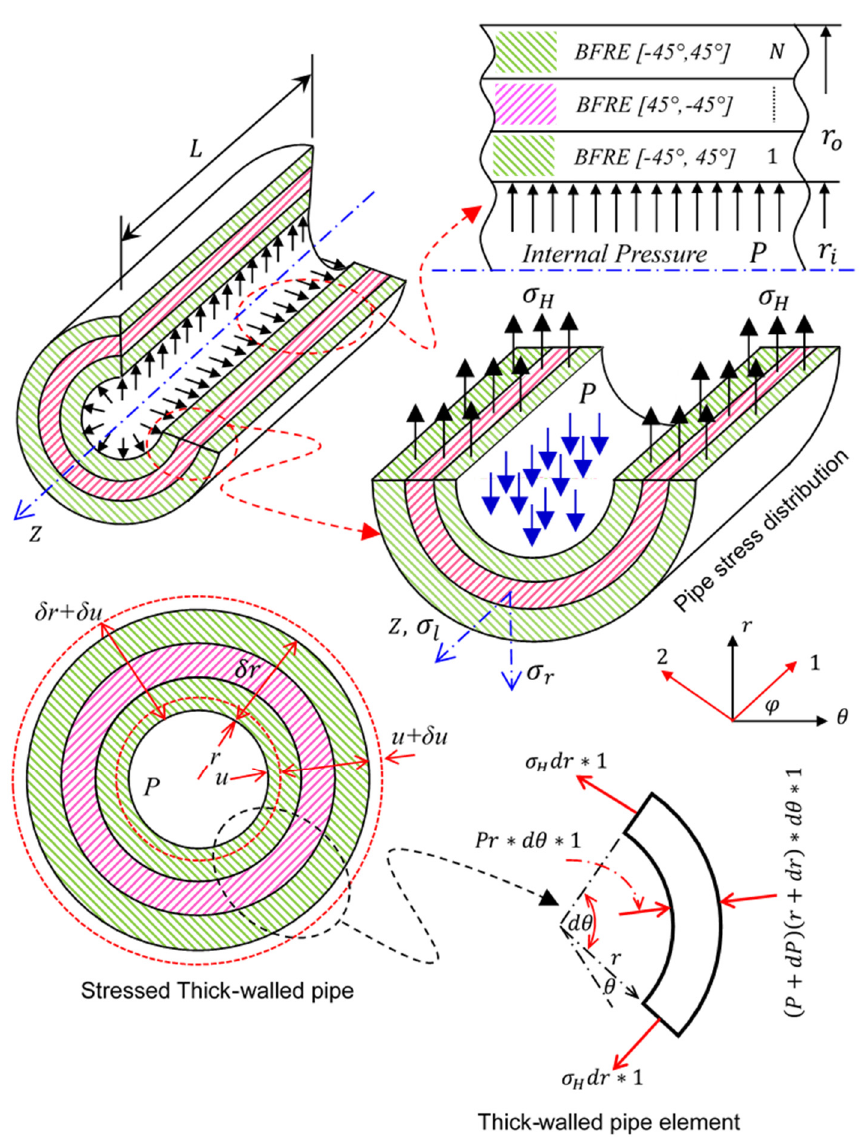
Figure 6. Stressed thick-walled pipe.